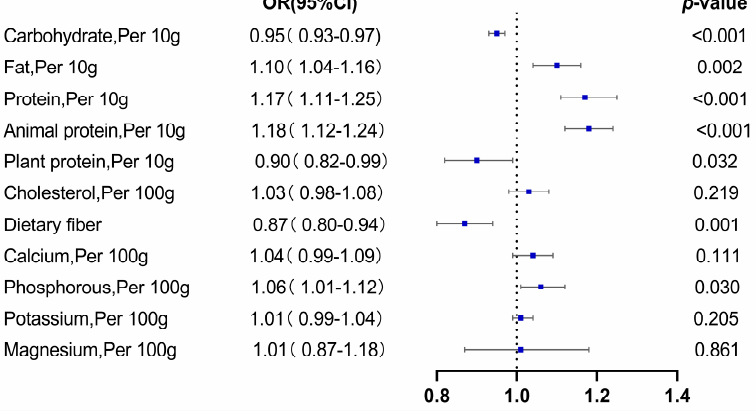
Figure 4. Dietary intake and hyperuricemia risk.